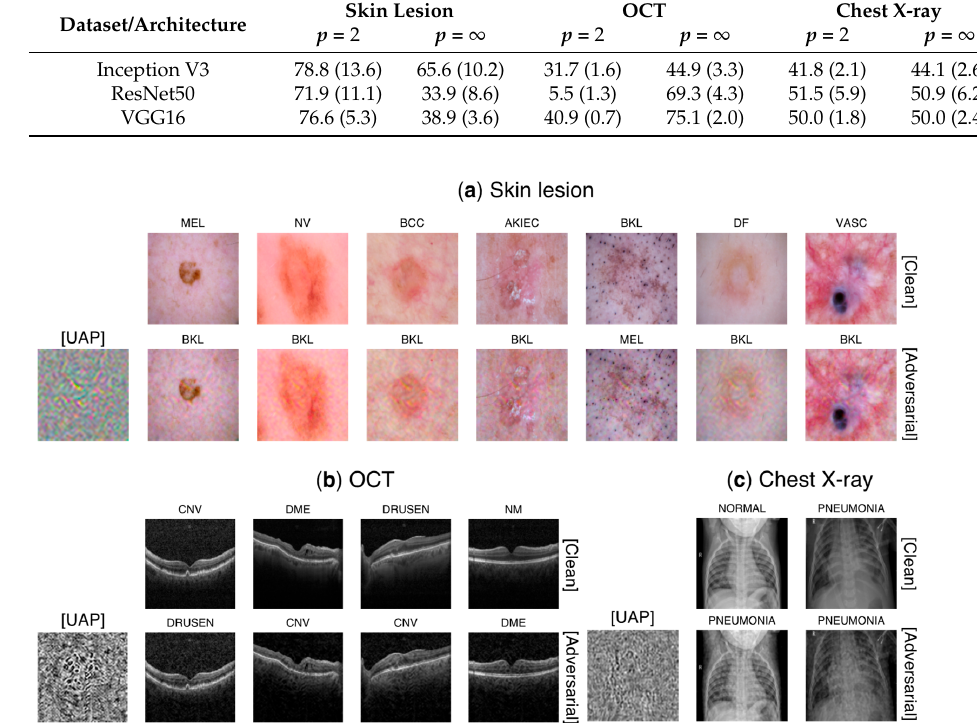
Table 1. Fooling rates R f (%) of UAPs for non-targeted attacks against DNN models for medical image datasets. Values in brackets indicate random controls ( R f of random UAPs). Dataset/Ar-